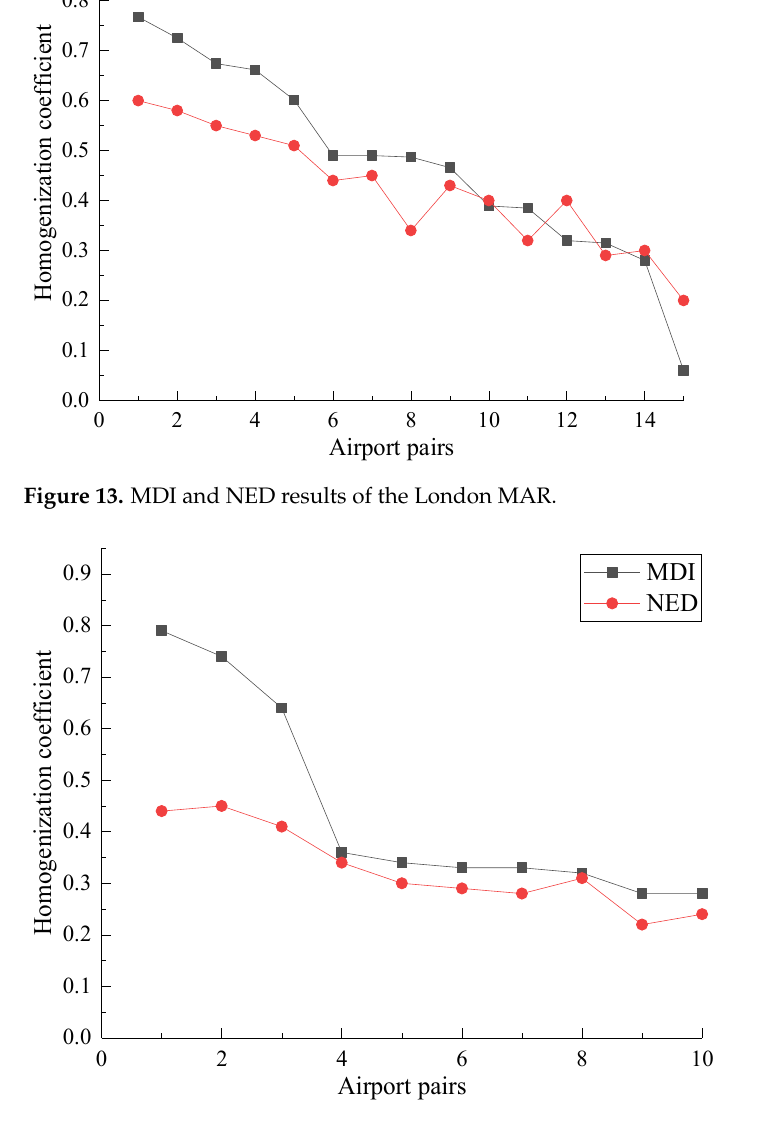
Figure 14. MDI and NED results of the New York MAR.